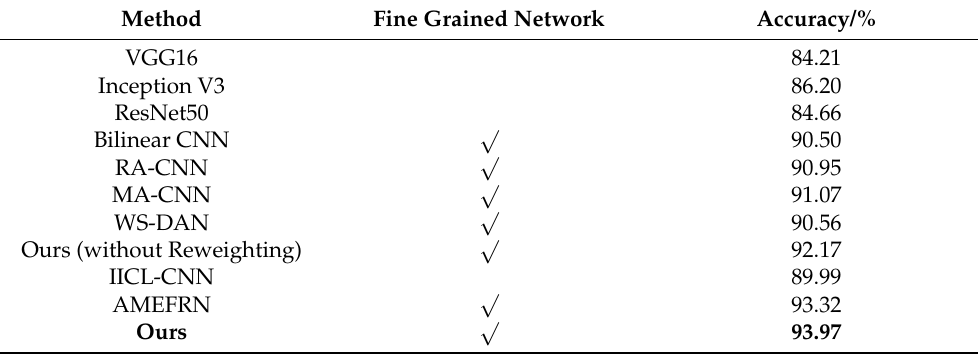
Table 9. Compared with other state-of-the-art methods on FGSCR-42 dataset. A check mark in the second column indicates that the method is a fine-grained method. Bold values indicate best